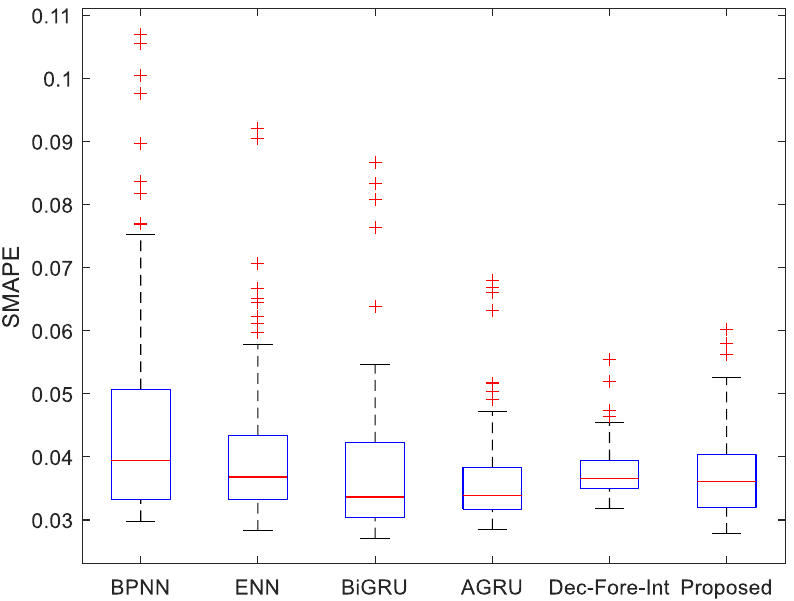
Figure 12. Accuracy results of different hybrid neural network models.